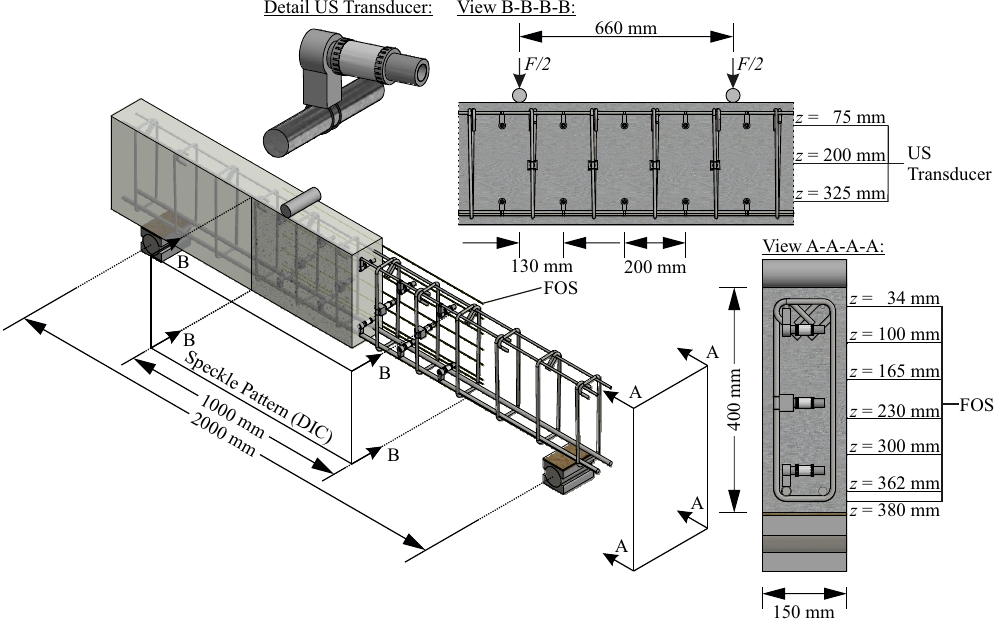
Figure 5. Model of the test